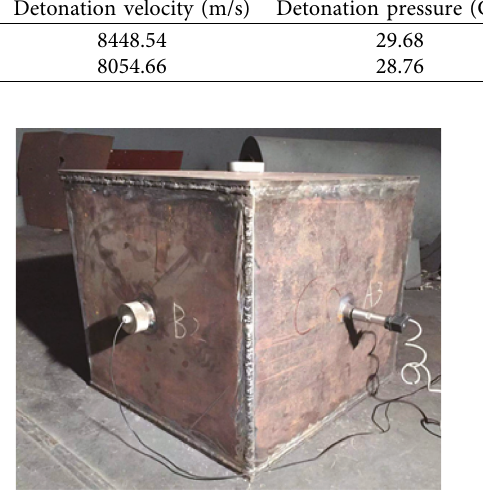
Figure 2: Structure of the simulation cabin.